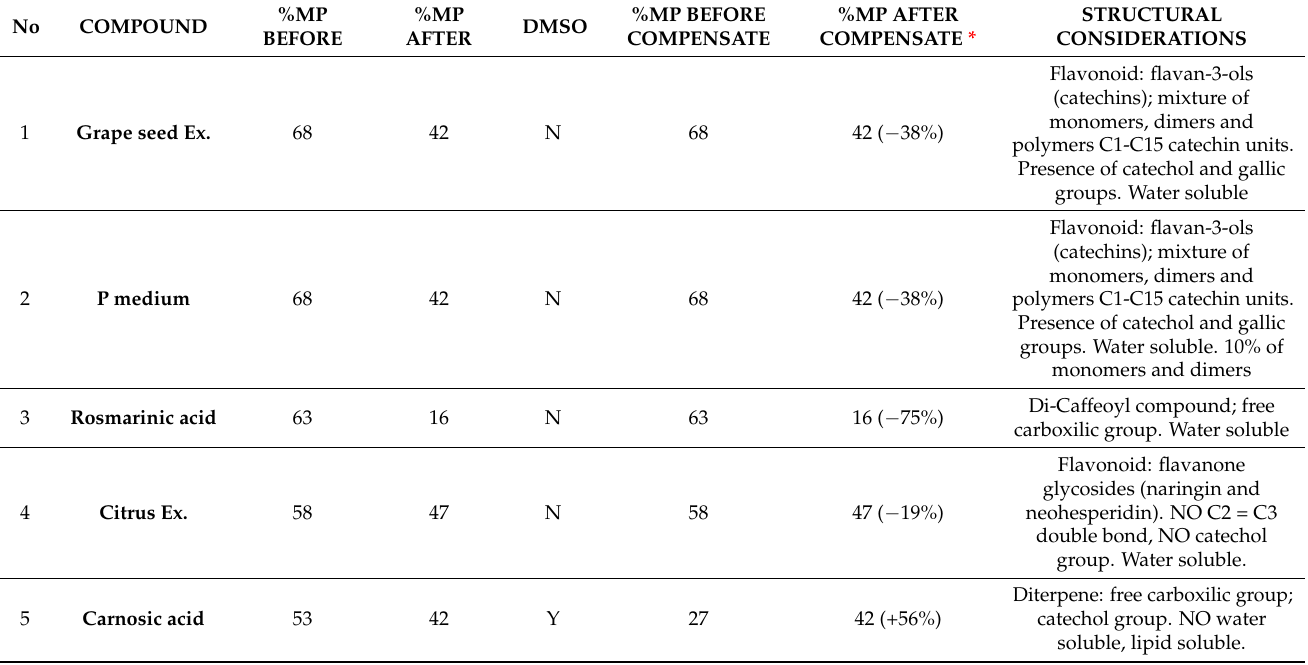
Figure 9. Compensated magnitudes of protection of the substances tested after eliminating possible additive effect of the DMSO used to solubilize the said substances for use in the biological environ- ment. Compensation was carried out on water-insoluble substances that were dissolved in DMSO. Compensated results are shown for substances administered before and immediately after exposure to ionizing radiation. Table 1. Structural characteristics of the tested substances related to the magnitude of protection (%) determined according to the time of their administration in relation to the exposure to X-rays, as well as modifications that could be due to a possible additive effect of the substances dissolved in